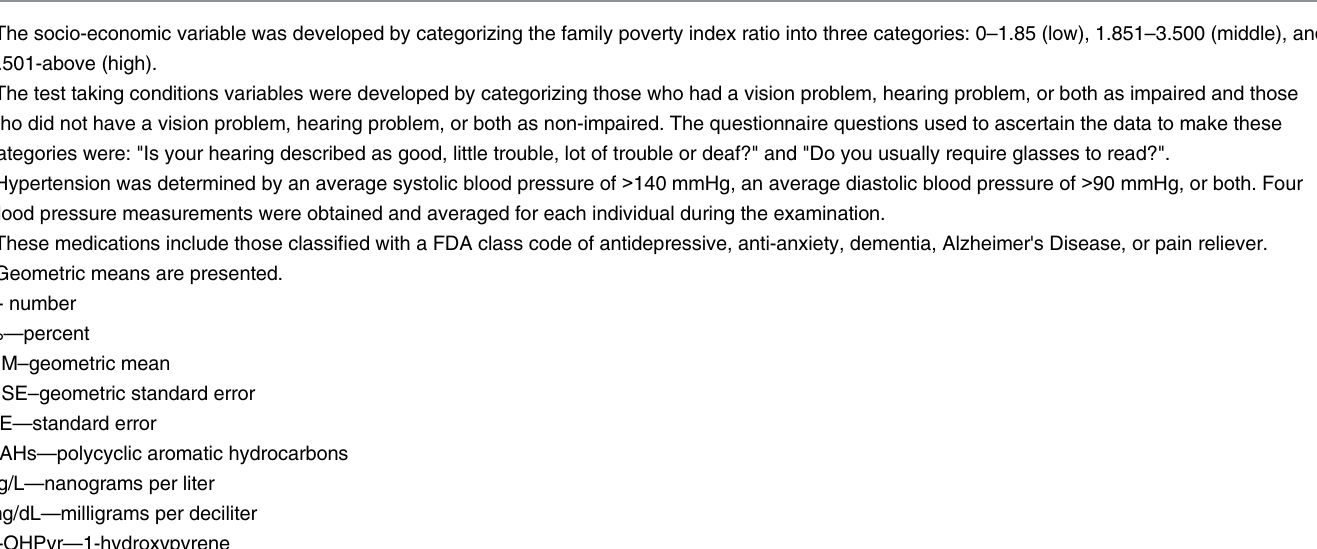
PAH metabolite concentrations compared to non-smokers (Table 3). The correlation between the urinary PAH metabolite concentrations and the DSST scores were low and in the negative direction, with Pearson correlation coefficients around -0.08 for all and p-values between 0.072 – 0.107 (Table 2). The highest DSST scores were observed for those classified as high SES; the lowest DSST scores were observed for those of low